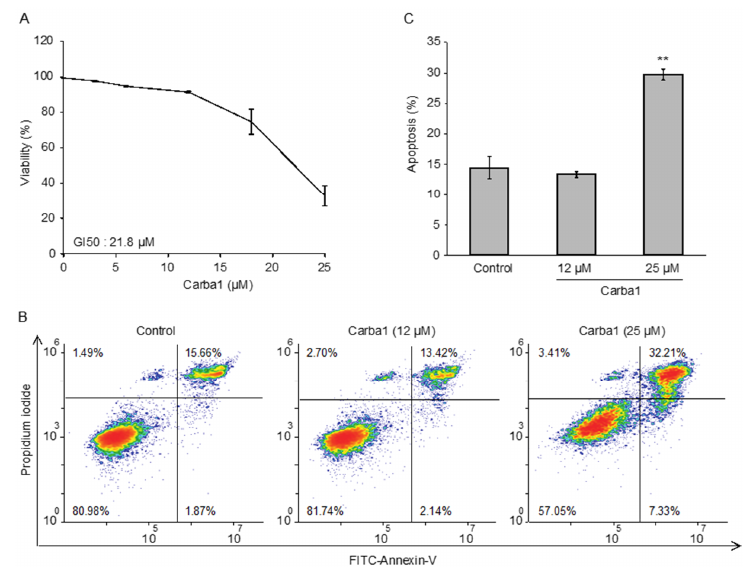
Figure 2. Carba1 has a low cytotoxicity. ( A ) Effect of Carba1 on HeLa cell viability. Cells were incubated for 72 h with increasing concentrations of Carba1. The percentage of viable cells was calculated following the Prestoblue assay. The results are expressed as mean ± SEM of three separate experiments. ( B ) Effect of Carba1 on HeLa cells apoptosis. HeLa cells, treated with the indicated concentrations of Carba1 for 72 h, were stained with propidium iodide and FITC-annexin V and analyzed by flow cytometry. Apoptotic cells are observed in the upper right part of the graphs. ( C ) Results for apoptotic cell death (as shown in Figure 2B) are expressed as mean ± SEM of three separate experiments. The significance was determined by a Student’s t -test (** p < 0.01, compared to the control).